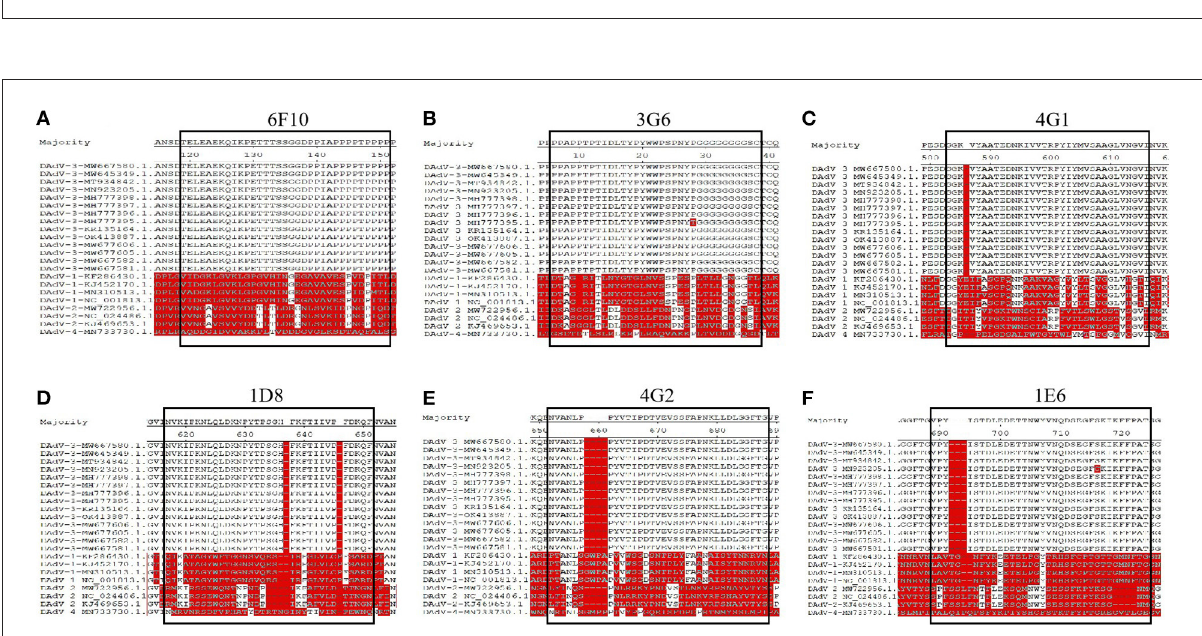
FIGURE5 Mapping the epitopes in Fiber-1 protein recognized by these mAbs. LMH cells transfected with the different Fiber-1 truncations were tested using mAb 6F10, 3G6, 4G1, 1D8, 4G2, and 1E6 by IFA.